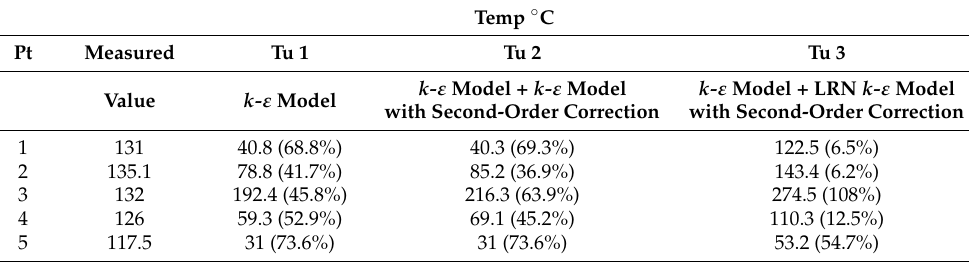
Figure 6. Comparison of predicted temperature: ( a ) at monitoring point Pt 1; ( b ) at monitoring point Pt 2; ( c ) at monitoring point Pt 3; ( d ) at monitoring point Pt 4; and ( e ) at monitoring point Pt 5. Table 2. Comparison of experimental and simulated results of temperature at 100 s.